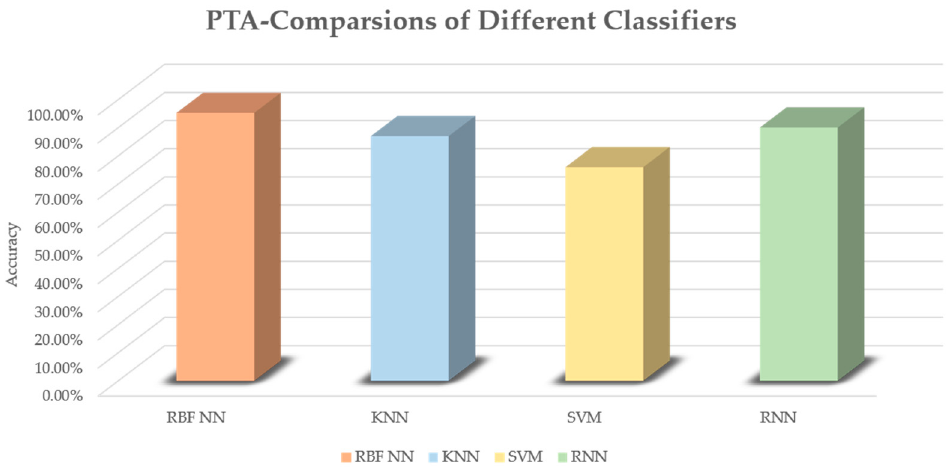
Figure 8. Evaluation of the proposed PTA (comparisons on different classifiers). Table 4. The performance comparison between related work and proposed PTA algorithm.